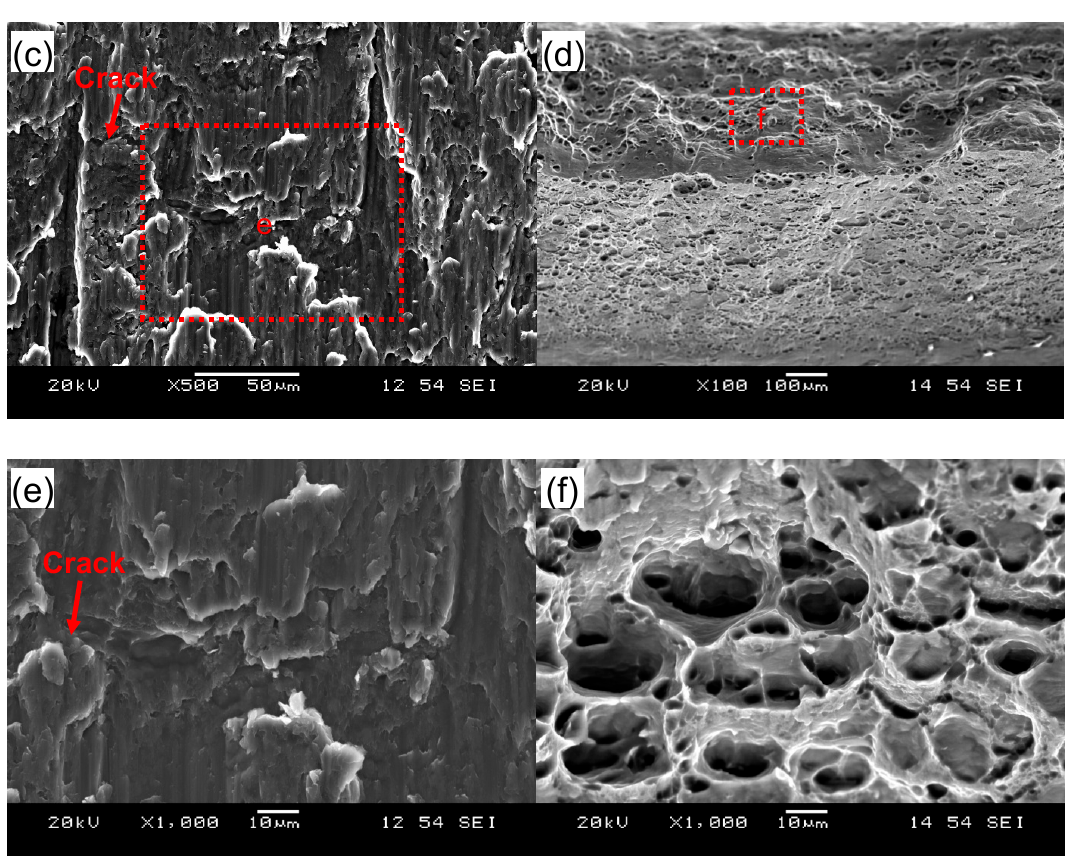
Figure 5. Typical SEM images of the tensile lap shear fracture surfaces of USWed joints of the 6022-T43 Al alloy made with a welding energy of 800 J ( a , c , e ) and 2000 J ( b , d , f ); with ( a , b ) showing an overall view; ( c , d ) at a lower magnification; and ( e , f ) at a higher magnification.